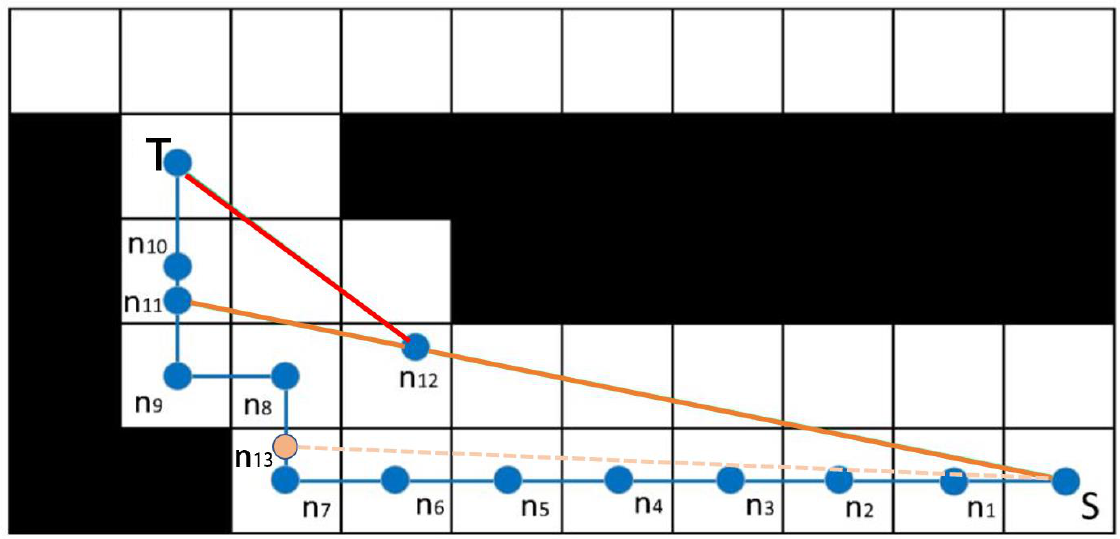
Figure 2. Raster path map (the starting point is S, and the target point is T).